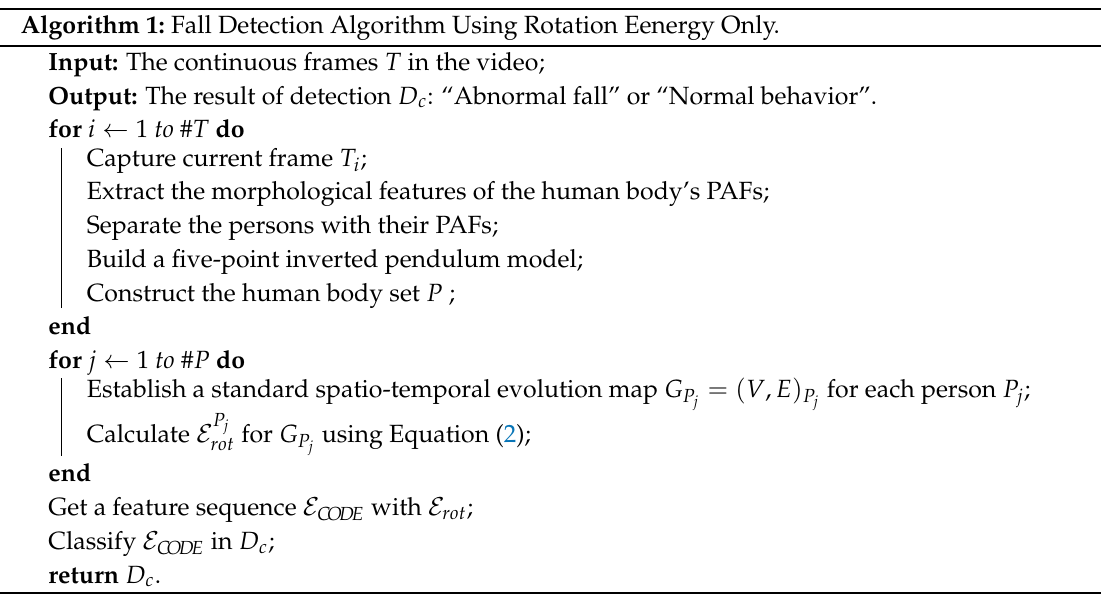
Algorithm 1: Fall Detection Algorithm Using Rotation Eenergy